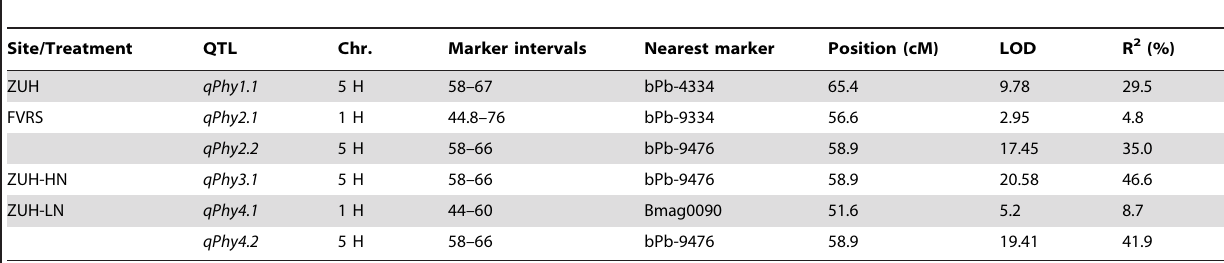
Table 1. QTLs for phytase activity in the DH population of Yerong/Franklin.